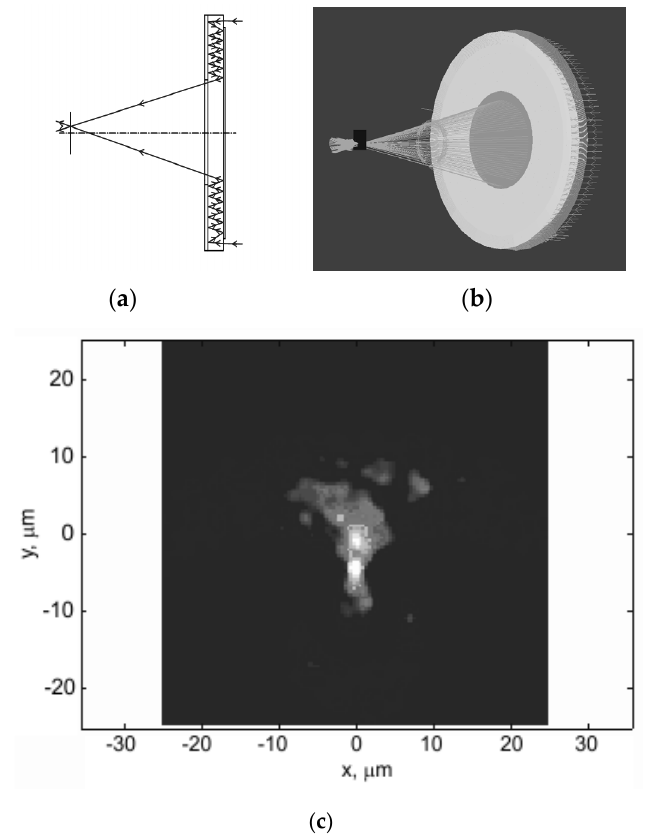
Figure 9. Ray paths in ( a ) two-dimensional and ( b ) three-dimensional cases, and ( c ) PSF.